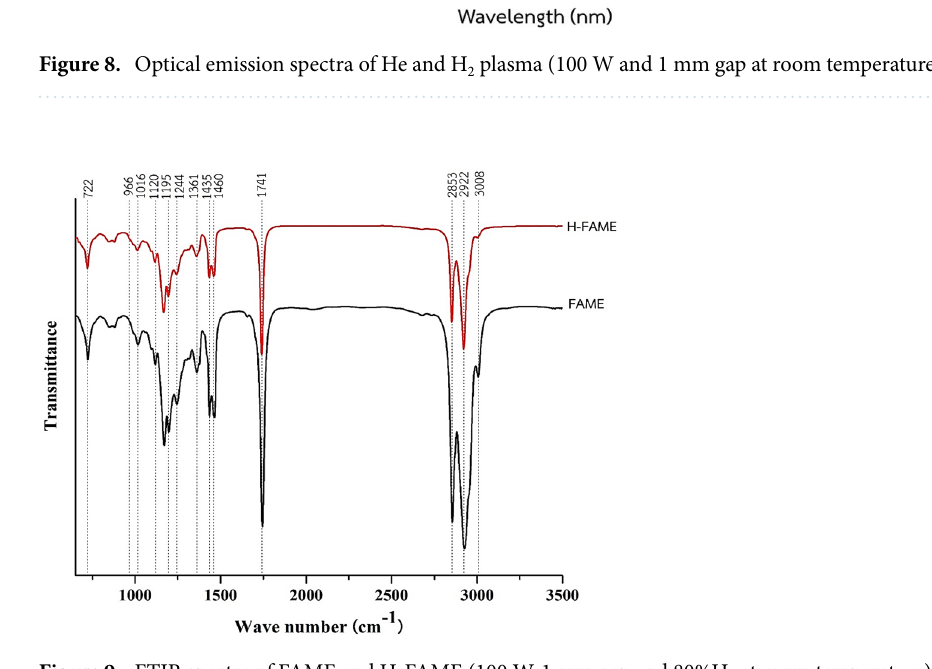
Figure 9. FTIR spectra of FAME and H-FAME (100 W, 1 mm gap and 80%H 2 at room